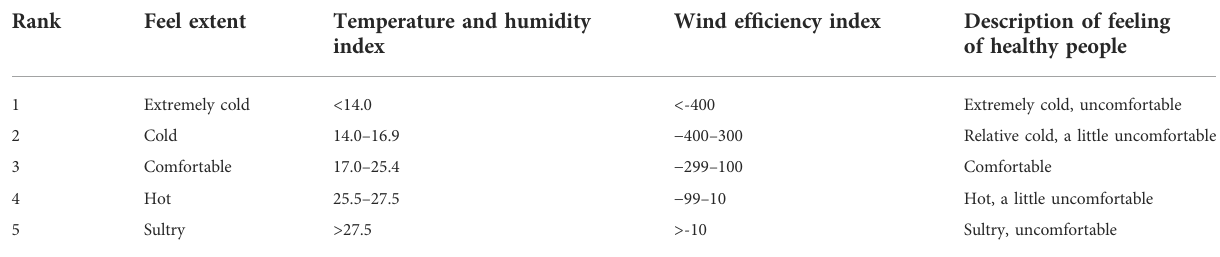
TABLE 2 Classi fi cation of climate comfort degree of human-settlement